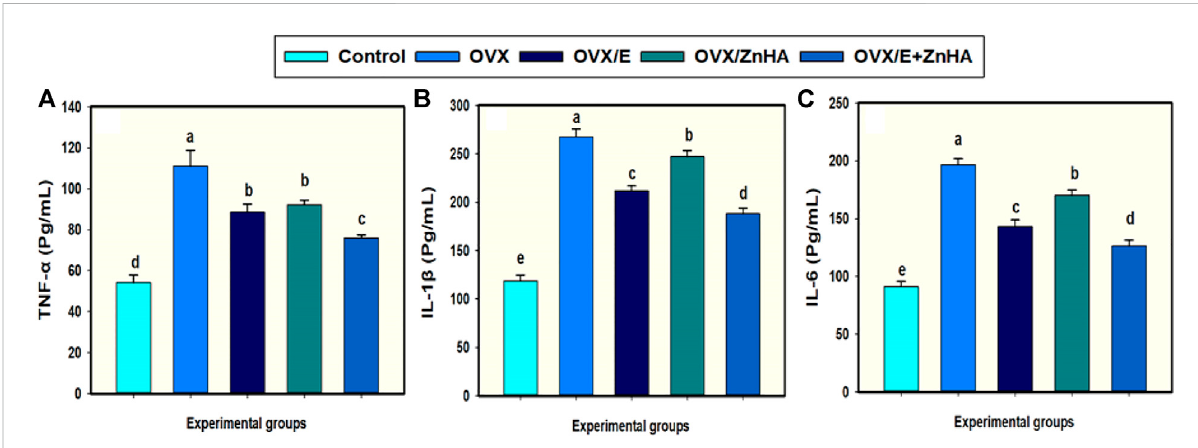
FIGURE 4 Effects of estrogen (E2) and/or zinc hydroxyapatite nanoparticles (ZnHA-NPs) on serum concentrations of cytokines in ovariectomized (OVX) rats. Data were expressed as mean ± SME ( n = 5/group, triplicate). Bars carrying different superscripts are signi fi cantly different ( p < 0.05). TNF- α , tumor necrosis factor-alpha (A) ; IL1B, Interleukin-1 β (B) ; IL-6, Interleukin-6 (C)